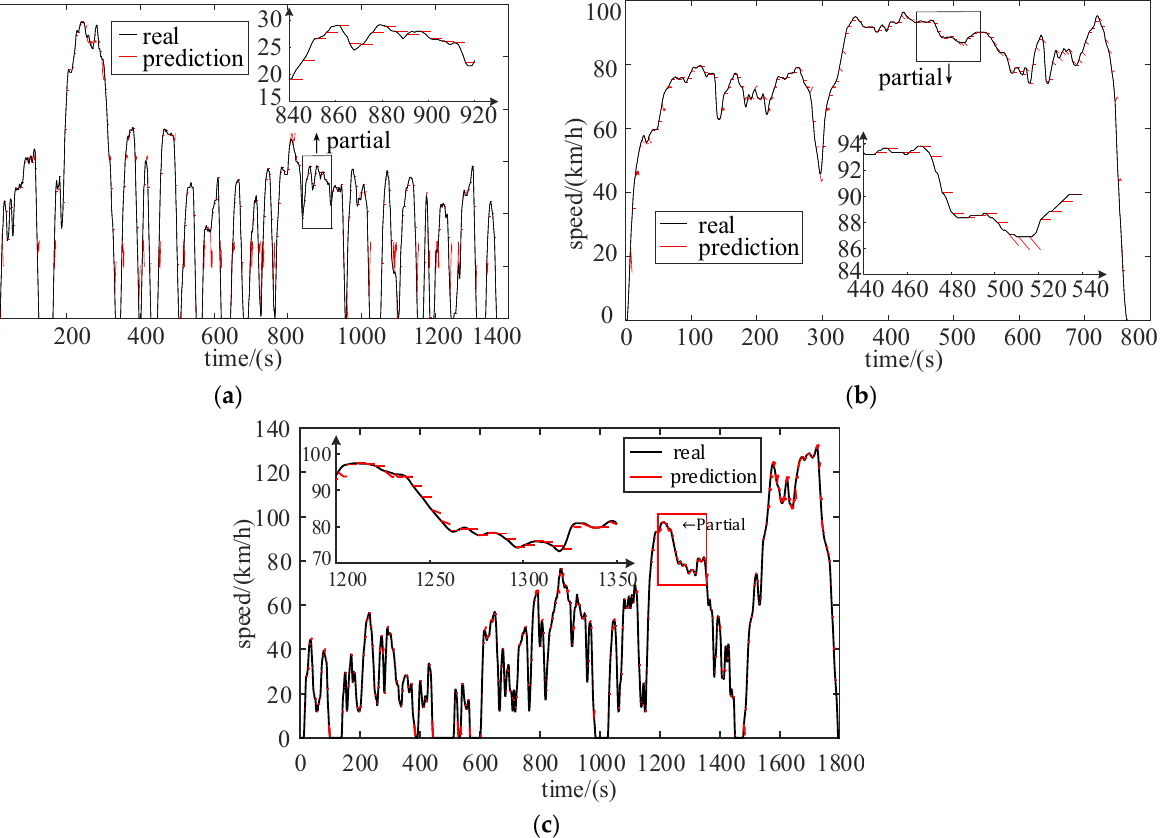
Figure 6. Speed prediction results. ( a ) Speed prediction of UDDS (urban); ( b ) Speed prediction of HWFET (highway); ( c ) Speed prediction of WLTC (mixed).